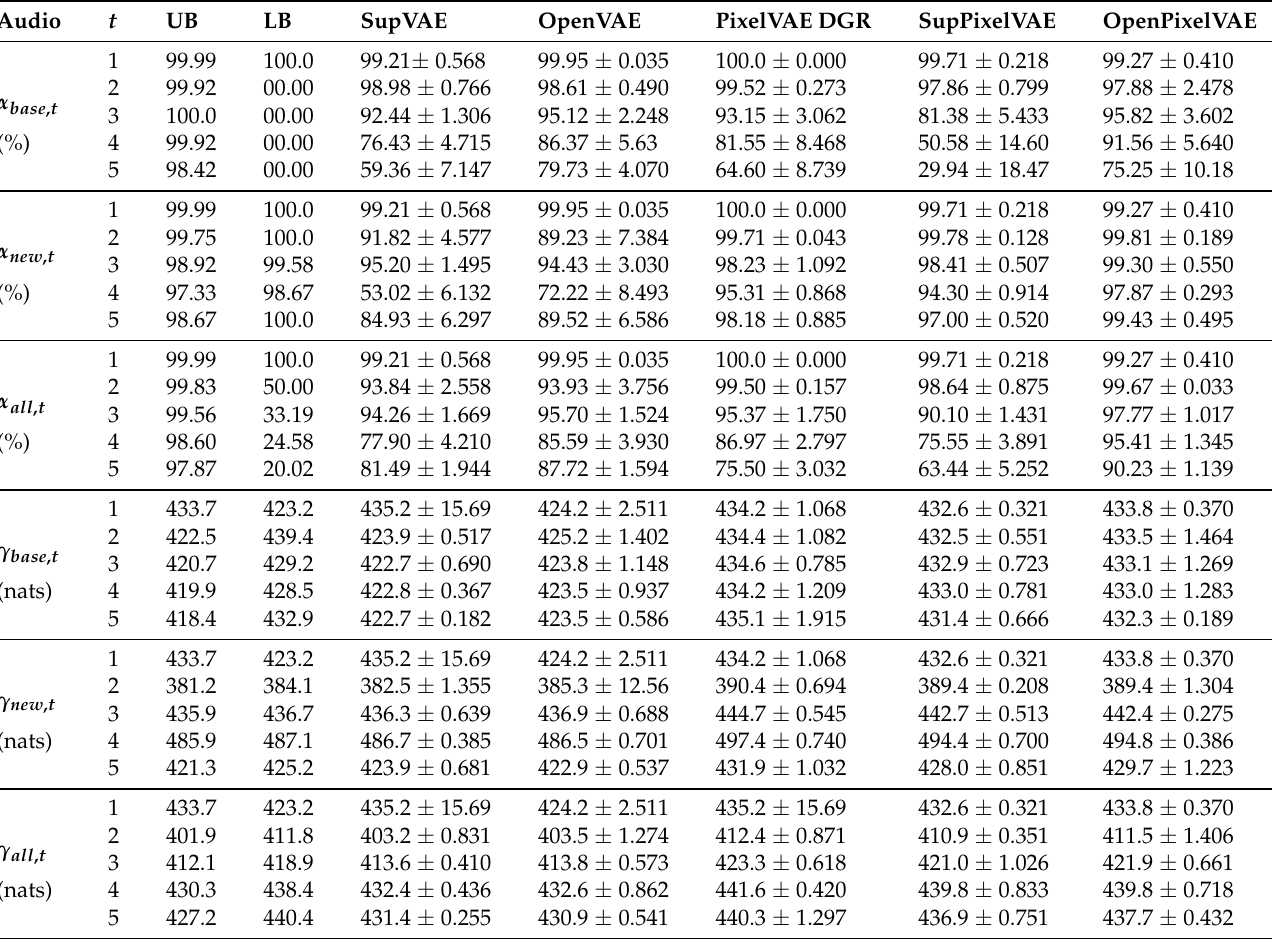
Table A7. The results for class incremental continual-learning approaches averaged over five runs, baselines and the reference isolated learning scenario for AudioMNIST at the end of every task increment. This is an extension of Table 3 in the main body. Here, in addition to the accuracy α t , γ t also indicates the respective NLL at the end of every task increment t